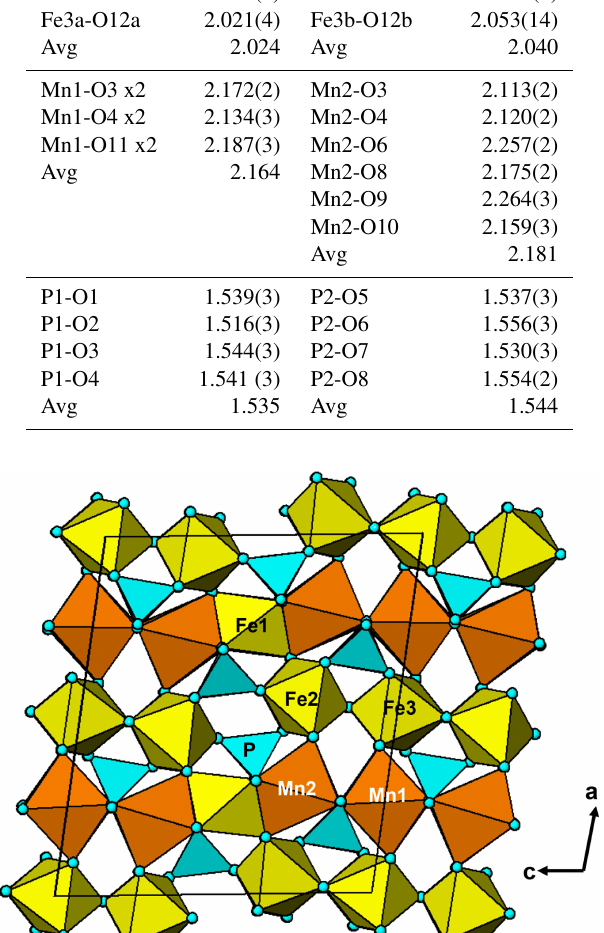
Figure 5. A [010] projection of the crystal structure of kenngot- tite, showing trimers of face-shared octahedra Mn2-Fe1-Mn2, con- nected into chains via edge sharing with Mn2-centred octahedra, and trimers of corner-connected octahedra Fe2-Fe3-Fe2 connected into chains via PO 4 tetrahedra.